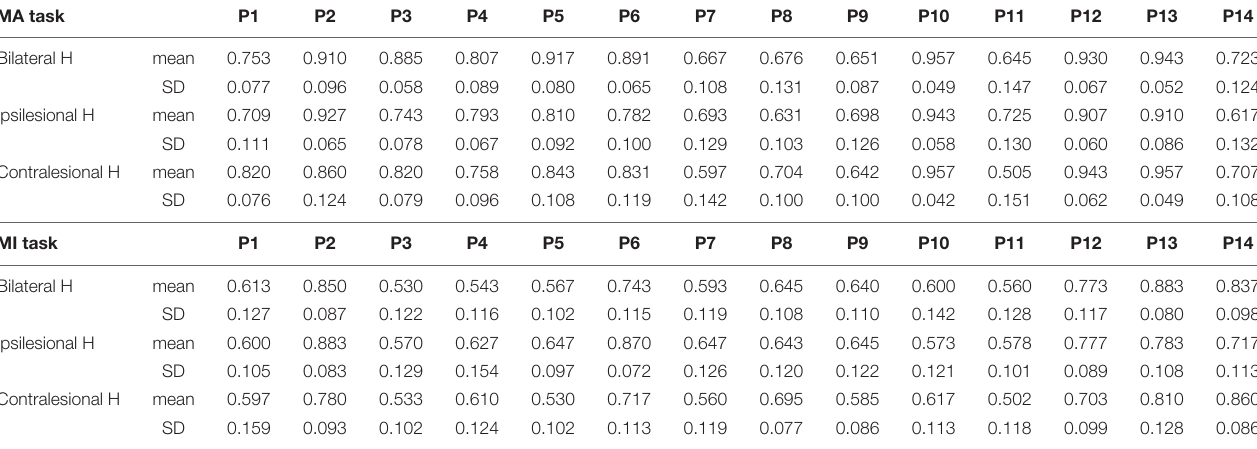
FIGURE 2 | The line chart and scatter plot of brain-computer interface (BCI) accuracies and event-related de/synchronization (ERD/ERS) values in the 8–30 Hz band. (A) The average BCI accuracies (mean ± SEM) between the MA and MI tasks in the bilateral, ipsilesional, and contralesional hemispheres. * p < 0.0167 after Bonferroni correction. (B) The average ERD/ERS values (mean ± SEM) between the MA and MI tasks in the bilateral, ipsilesional, and contralesional hemispheres. (C) The average ERD/ERS values (mean ± SEM) between the MA and MI tasks in the C3/C4 channels. SEM, standard error of mean. TABLE 2 | The BCI accuracy and variance of accuracy for each patient in the MA and MI tasks,